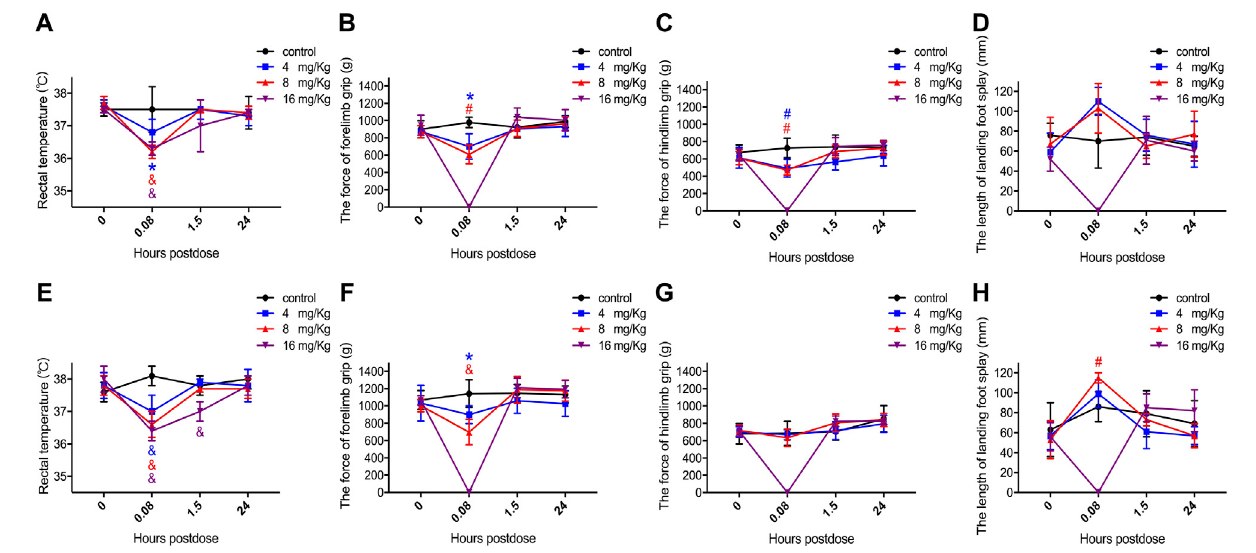
FIGURE 4 | The value of rectal temperature, forelimb grip force, hindlimb grip force and landing foot splay length in male (A – D) and female (E – H) rats. Data were depicted as the mean ± SD. Compared with control group, * p < 0.05; # p ≤ 0.01; & p ≤